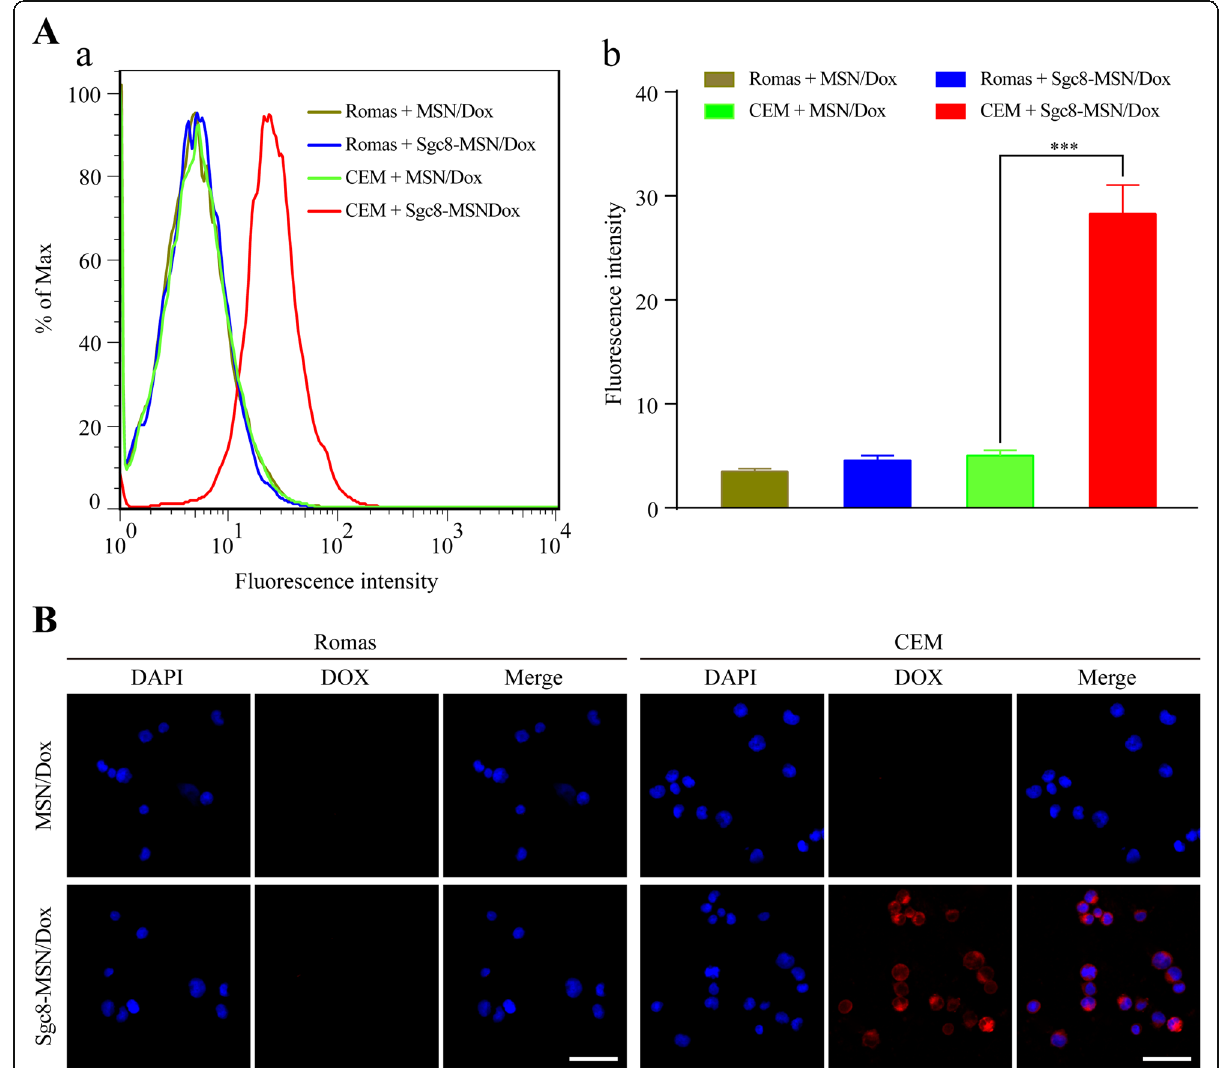
Fig. 5 In vitro targeting of leukemia cells by Sgc8-MSN/Dox analyzed using a flow cytometry and b fluorescence microscopy. CCRF-CEM and Romas cells were incubated with MSN/Dox orSgc8-MSN/Dox, and then stained with DAPI (blue). Dox appeared red.